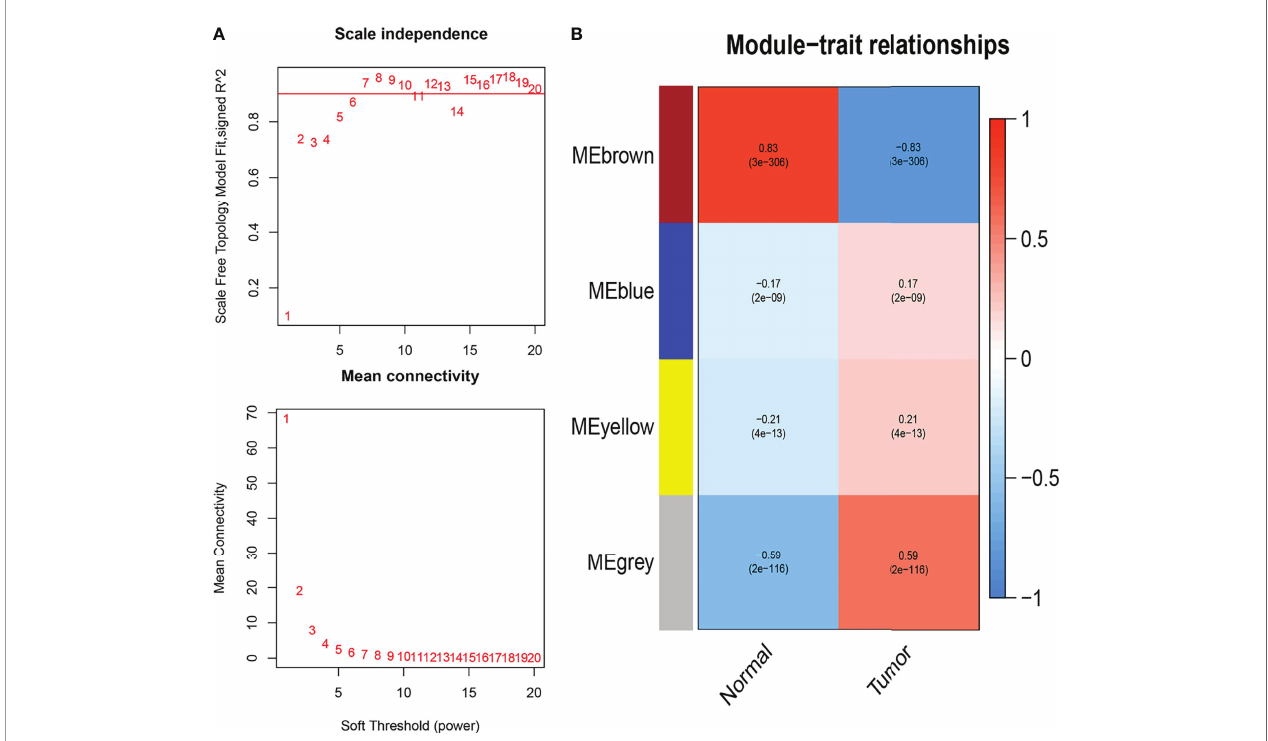
FIGURE 1 | Weighted co-expression network analysis (WGCNA) of immune-related differential genes. (A) Determining the soft threshold power in WGCNA analysis. (B) Gene modules related to BC obtained by